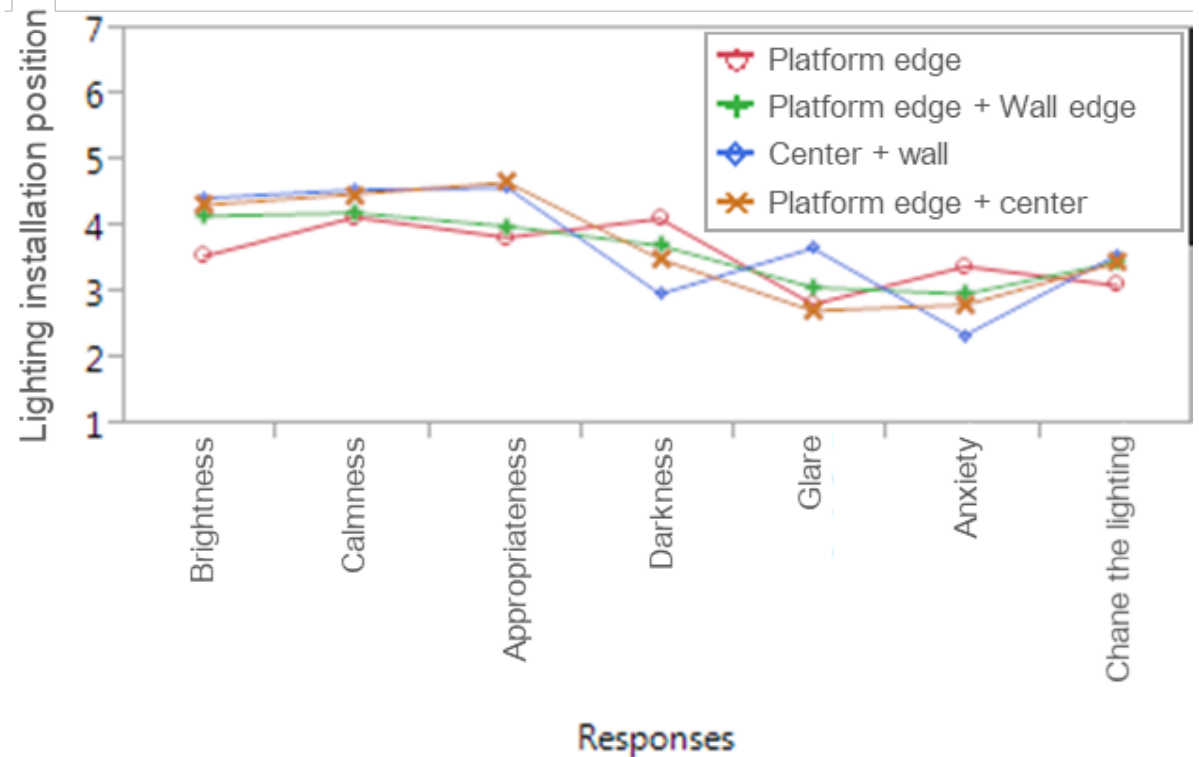
Figure 19. Significant differences depending on the lighting installation position.